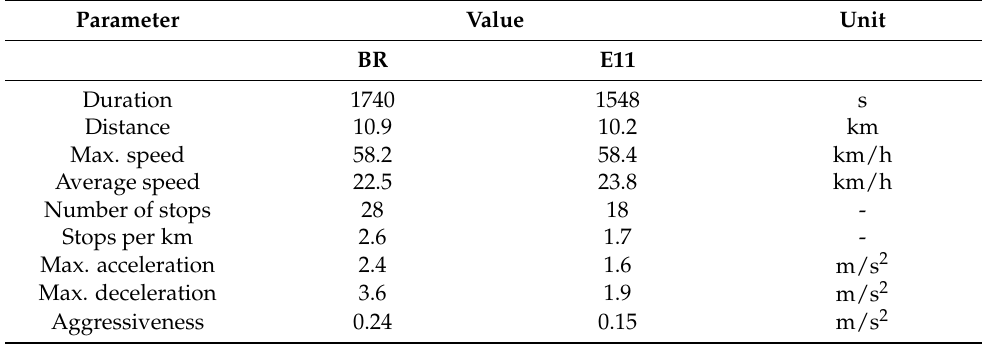
Table 2. Characteristic parameters of the BR and E11 driving cycle [29].